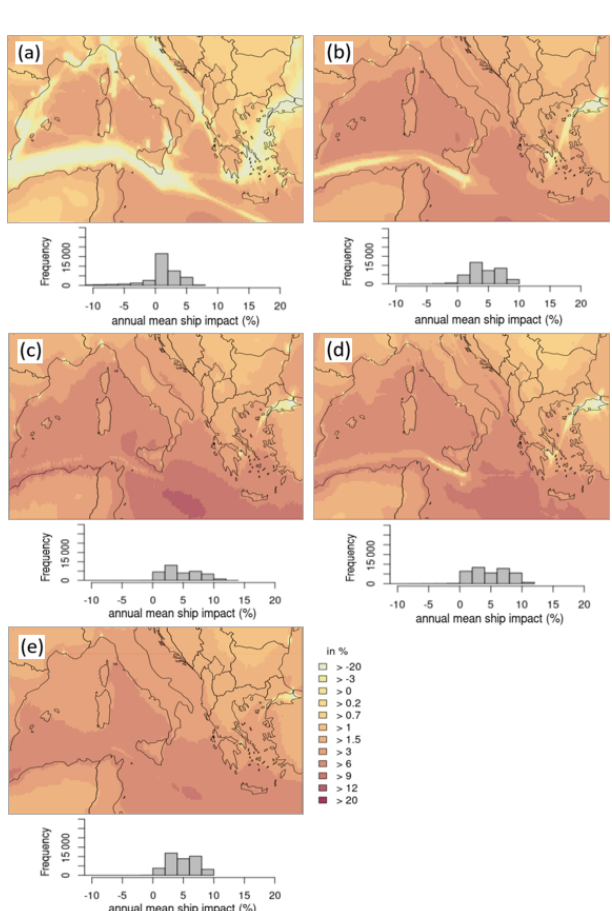
Figure 8. Annual mean O 3 total concentration. (a) CAMx; (b) CHIMERE; (c) CMAQ; (d) EMEP; (e) LOTOS-EUROS; the panels show the emisbase spatial distribution and the annual mean value, and white areas contain values below 60µgm − 3 . Below the domain figure the respective frequency distribution is displayed for the annual mean O 3 concentration, referring to the whole model domain.